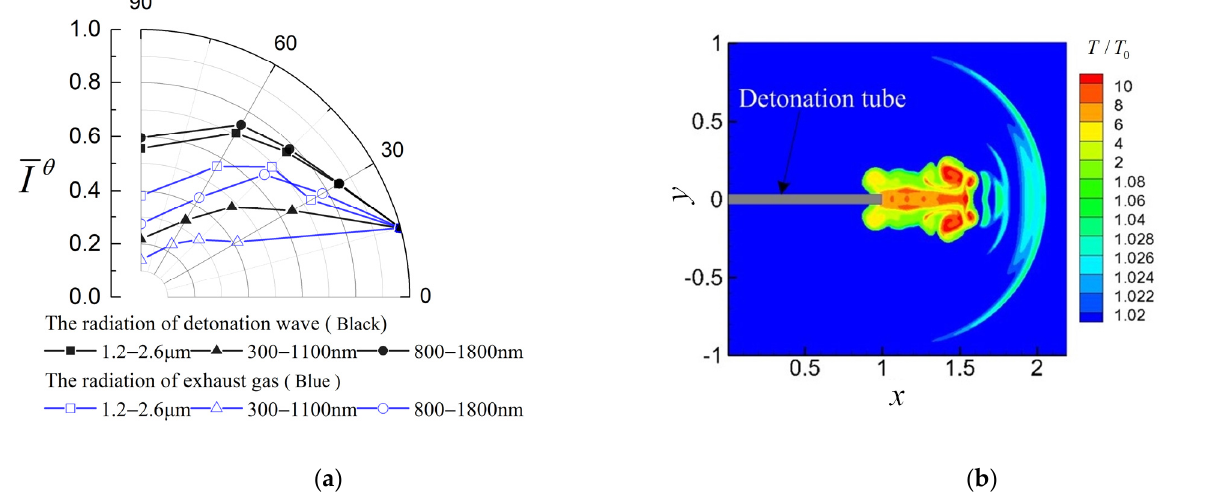
Figure 5. ( a ) Directivity distribution of radiation signals in different bands, ( b ) Temperature nephogram of detonation.